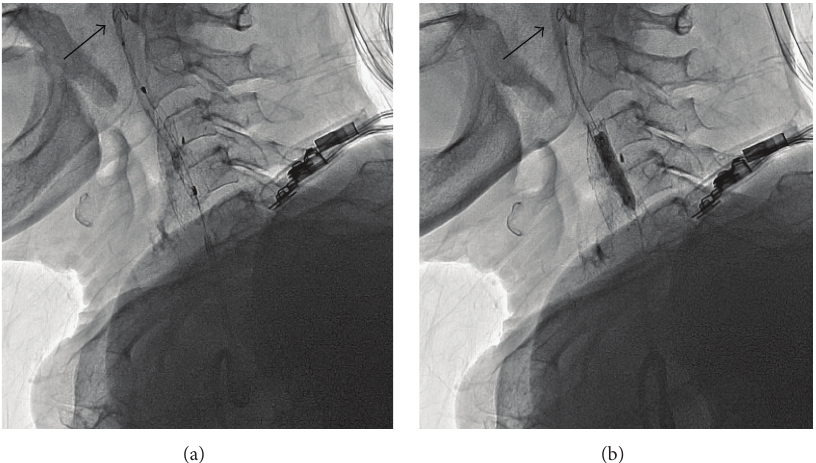
Figure 5: Self-expandable stent deployment (a) and postdilation (b) was performed after placement of the distal embolic protection system (black arrows) in the left internal carotid